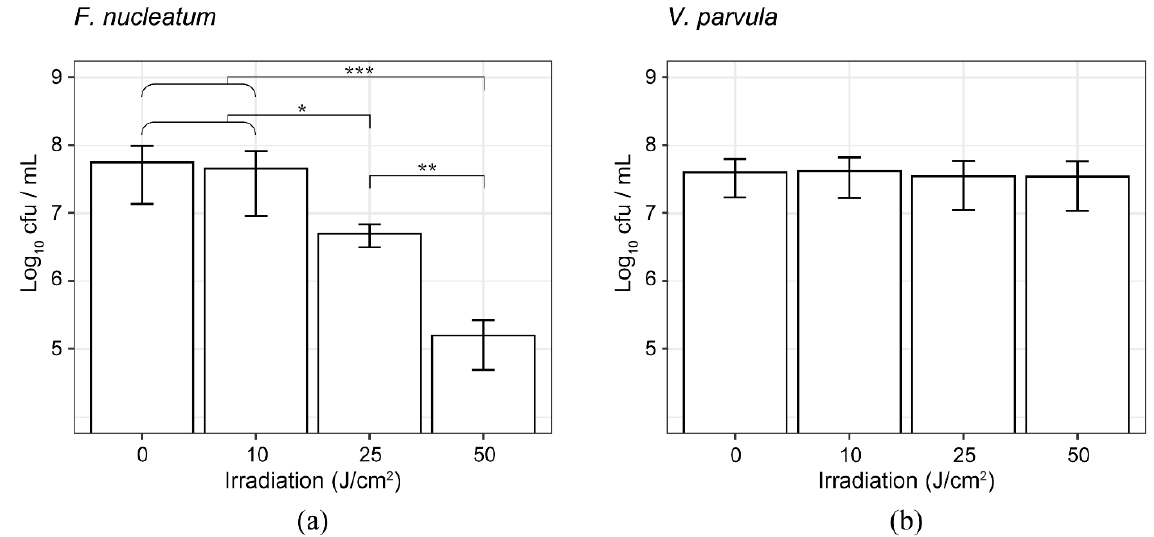
Figure 7. Effect of violet LED irradiation on the bacterial cell viability. ( a ) Bacterial viability of F. nucleatum subsp. polymorphum at different violet LED irradiation doses. Each value is calculated from quadruplicate assays, presented as the mean ± standard deviation. ( b ) Bacterial viability of V. parvula at different violet LED irradiation doses. Each value is calculated from quintuplicate assays, presented as the mean ± standard deviation (* p < 0.05, ** p < 0.01, *** p < 0.001, Student’s t -test).